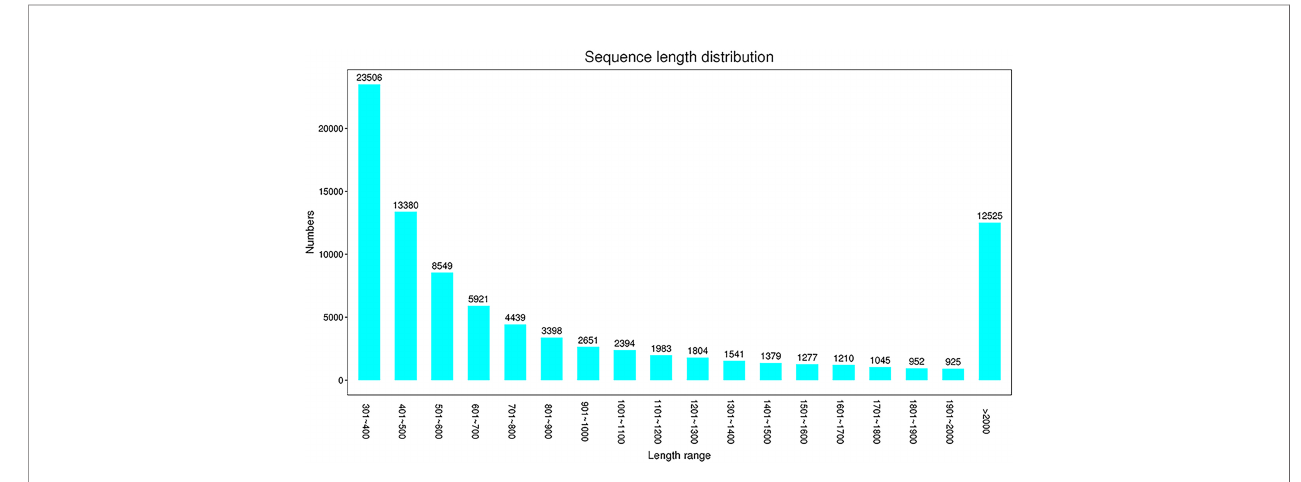
FIGURE 1 | Unigene Length distribution. X-axis is the sequence length range, Y-axis is the